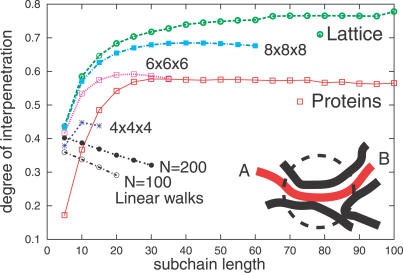
Degree of Interpenetration of SubchainsDefined as follows: given a labeled subchain (say chain AB in the inset at the lower right), determine the fraction of the number of units (or residues) of the loop or protein enclosed within a sphere (dashed circle) that does not belong to the subchain. The radius of this enclosing sphere is equal to the gyration radius of the subchain. The degree of interpenetration is then defined as an average of this quantity over all subchains of the given length, taken within a single protein chain and from all other protein chains. As in the results for the mean square end-to-end distance, for each chain of length N, we consider subchains of length up to N2/3. The degree of interpenetration for proteins, lattices (average from five globular loop sizes from 4 × 4 × 4 to 12 × 12 × 12, and separately for 4 × 4 × 4, 6 × 6 × 6, and 8 × 8 × 8) and linear equilateral random walks of length N = 100 and N = 200 are shown.